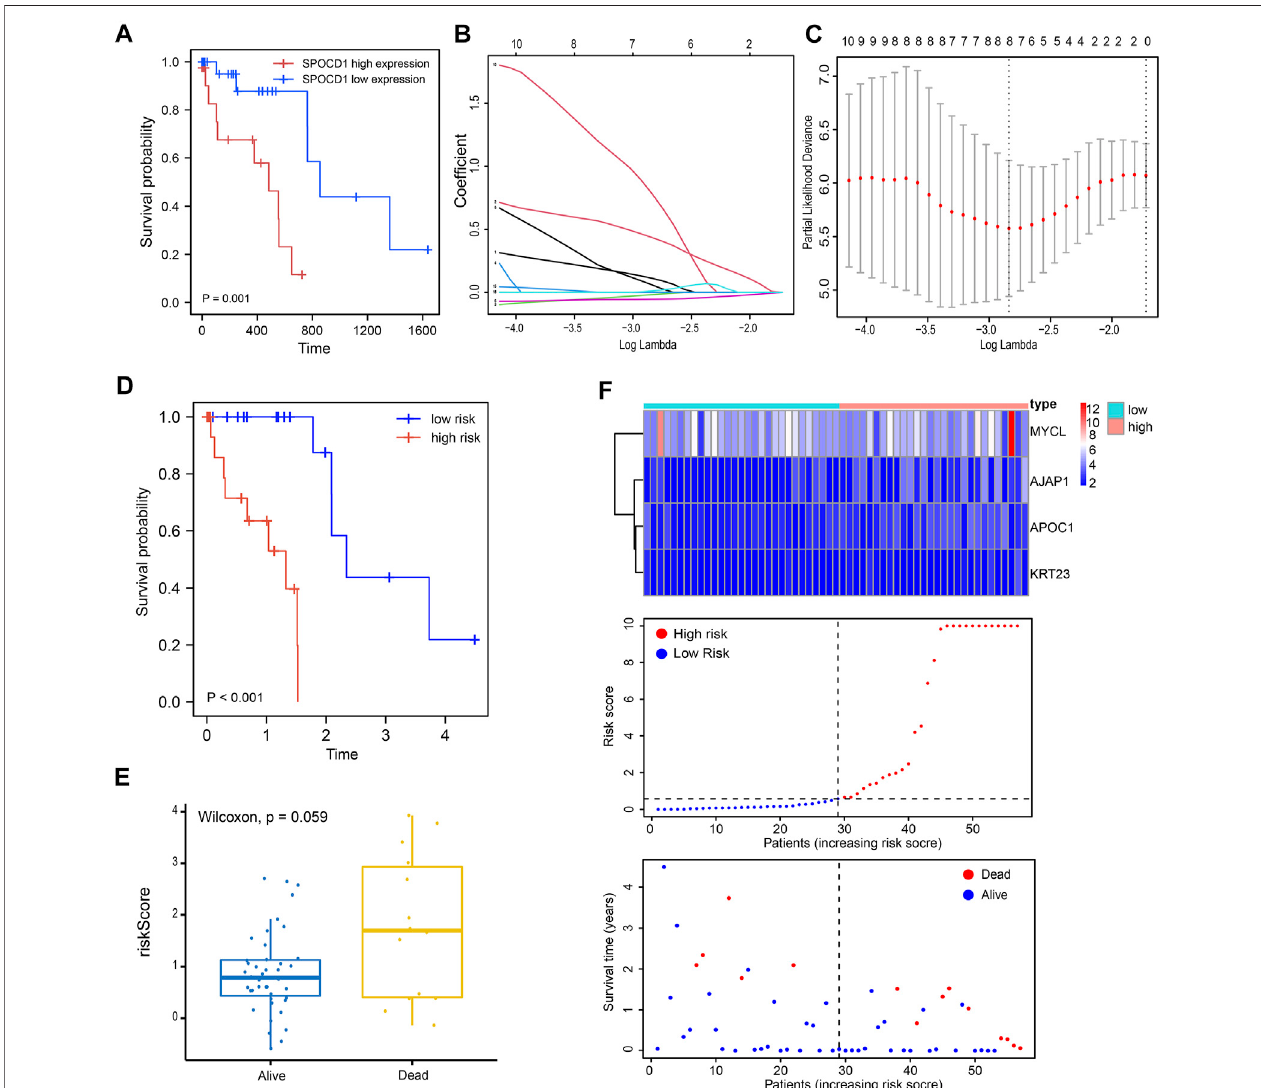
FIGURE 10 | Prognosis correlation analysis of SPOCD1. (A) The prognosis of the low SPOCD1 expression group was signi fi cantly better than that of the high expression group; (B,C) From Lasso regression to multivariate Cox regression: λ and cv maps showed that eight factors were screened; (D) The prognosis of patients withthehigh-riskscorewasworsethanthatofpatientswithlowrisk; (E) Theriskscoreofthedeathgroupwassigni fi cantlyhigherthanthatofthesurvivalgroup; (F) Risk heat map and scatter map of independent prognostic genes in multivariate Cox regression. SPOCD1, SPOC Domain Containing